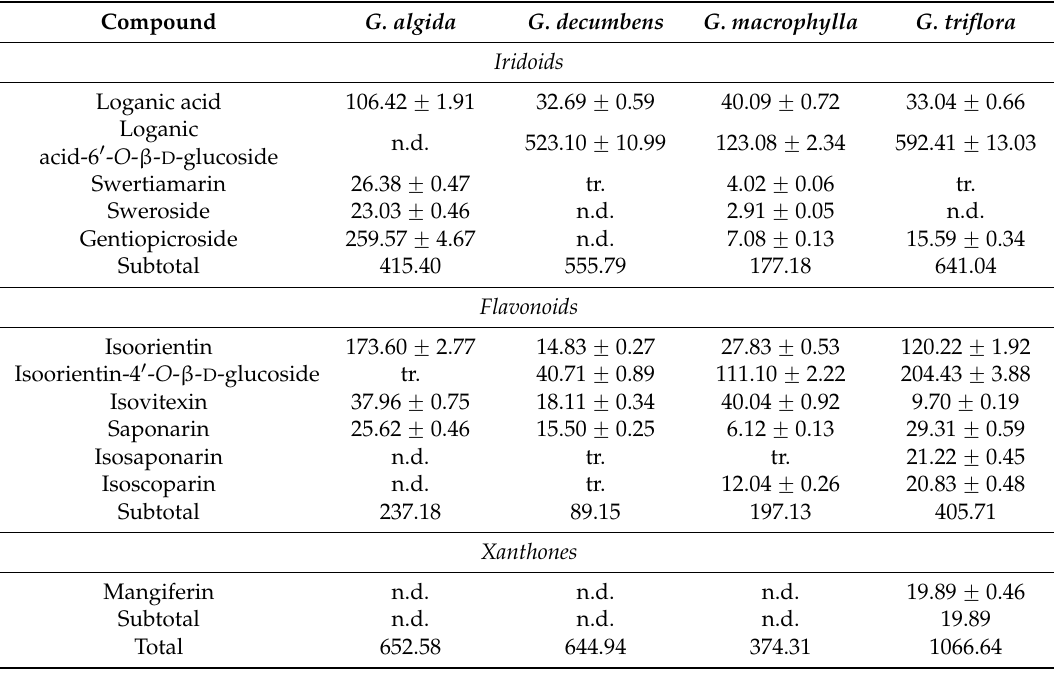
Table 2. Content of iridoids, flavonoids and mangiferin in bitter gentian tea decoctions, µ g/mL ( ˘ SD).